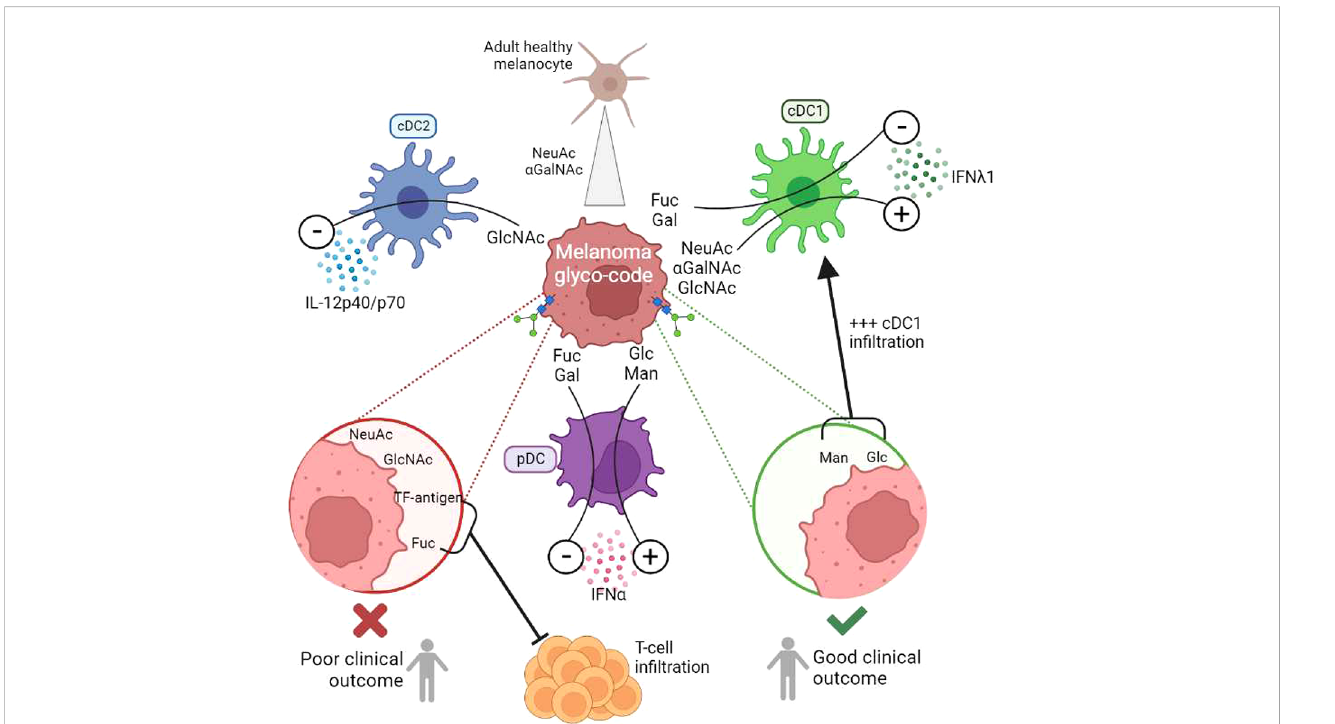
FIGURE 8 (Graphical summary): Melanoma tumor glyco-code impacts DC subsets ’ functionality, dictates the nature of immune in fi ltrate, and drives patients ’ clinical outcome. To decrypt potential links between aberrant glycosylation patterns and immune evasion in melanoma, we explored the melanoma tumor glyco-code through the GLYcoPROFILE ™ methodology (lectin arrays), and depicted its impact on patients ’ clinical outcome and DC subsets ’ functionality. Primary tumor cells derived from melanoma patients harbored a speci fi c glyco-code characterized by high levels of GalNAc and NeuAc residues compared to healthy melanocytes, with heterogeneous expression of Man, Fuc and Gal motifs. Speci fi c glycan patterns on tumor cells correlated with clinical outcome of melanoma patients, especially GlcNAc, NeuAc, TF-Ag and Fuc motifs being associated with poor outcome, whereas Man and Glc residues eliciting better survival. Strikingly, tumor cells which differentially impacted cytokine production by DC subsets harbored distinct glyco-pro fi les. GlcNAc exhibited a negative in fl uence on cDC2s, whereas Fuc and Gal motifs displayed inhibitory impacts on cDC1s and pDCs. We further identi fi ed a GalNAc, GlcNAc and NeuAc as potential booster glycans for cDC1s, and Man/Glc for pDCs. Targeting speci fi c glycans on melanoma tumor cells blocked their negative impact on DC subsets and restored potent DCs ’ functionality. The tumor glyco-code was also linked to the nature and magnitude of the immune in fi ltrate, as levels of Man/Glc and GlcNAc residues positively correlated with proportions of tumor-in fi ltrating cDC1s, and levels of Fuc and TF-Ag residues negatively correlated with in fi ltration by T